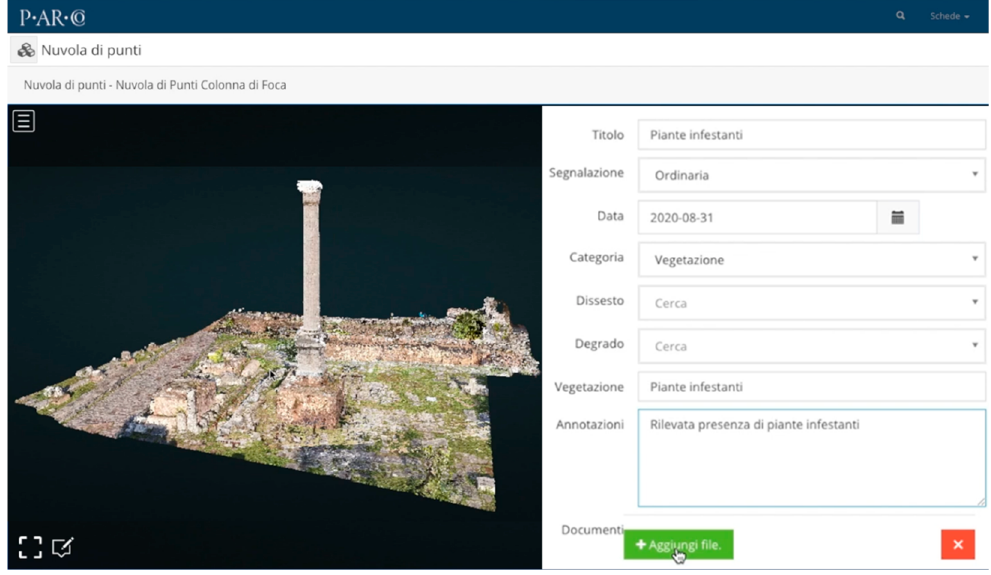
Figure 11. SyPEAH, signaling dashboard: the compilation of the report form is facilitated by the visualization of the monument also in 3D.